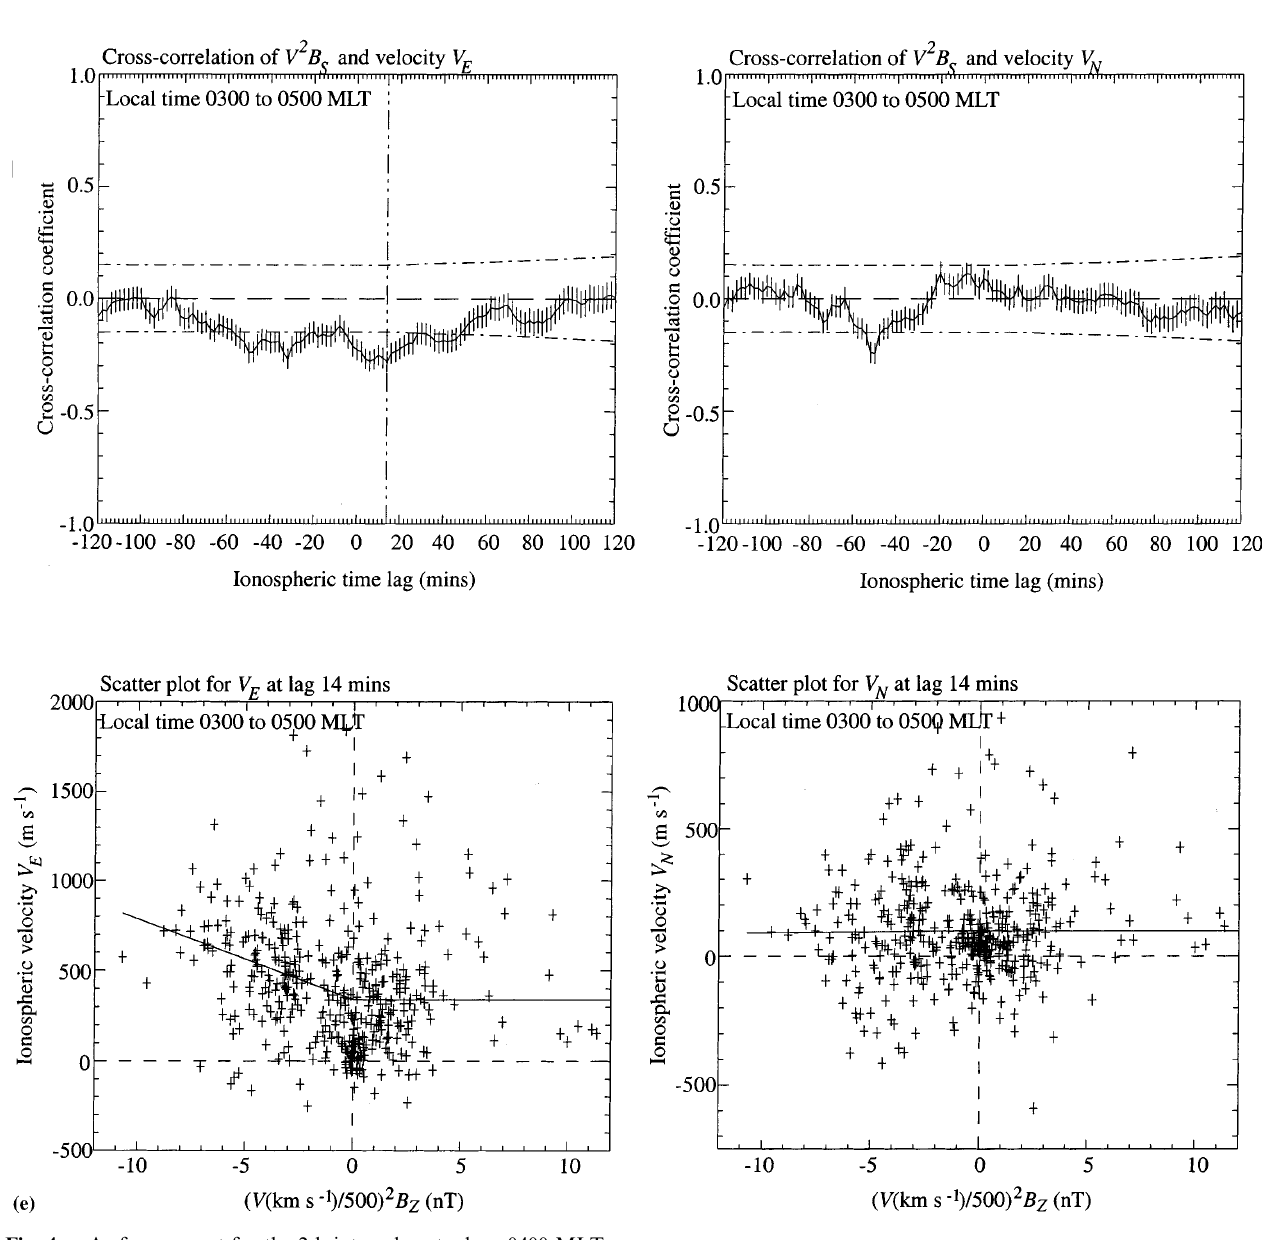
Fig. 4. e As for a except for the 2-h interval centred on